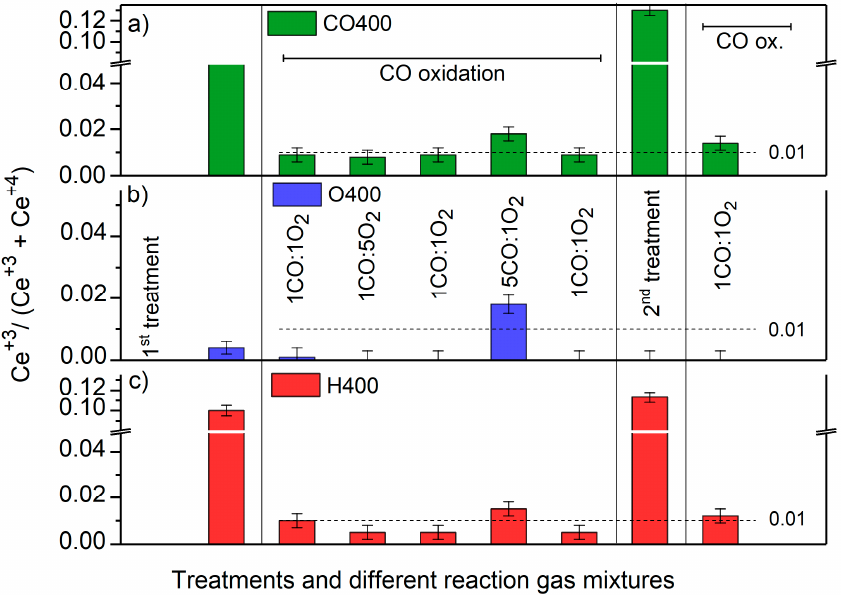
Figure 7. Overview about changes in the Ce 3+ concentration in Au/CeO 2 catalysts during CO oxidation ( a ) after CO400 pretreatment, ( b ) after O400 pretreatment, and ( c ) after H400 pretreatment in a sequence of varying reaction gas atmospheres. The left and right parts refer to the reaction in standard reaction gas mixture following the first and the second treatment.